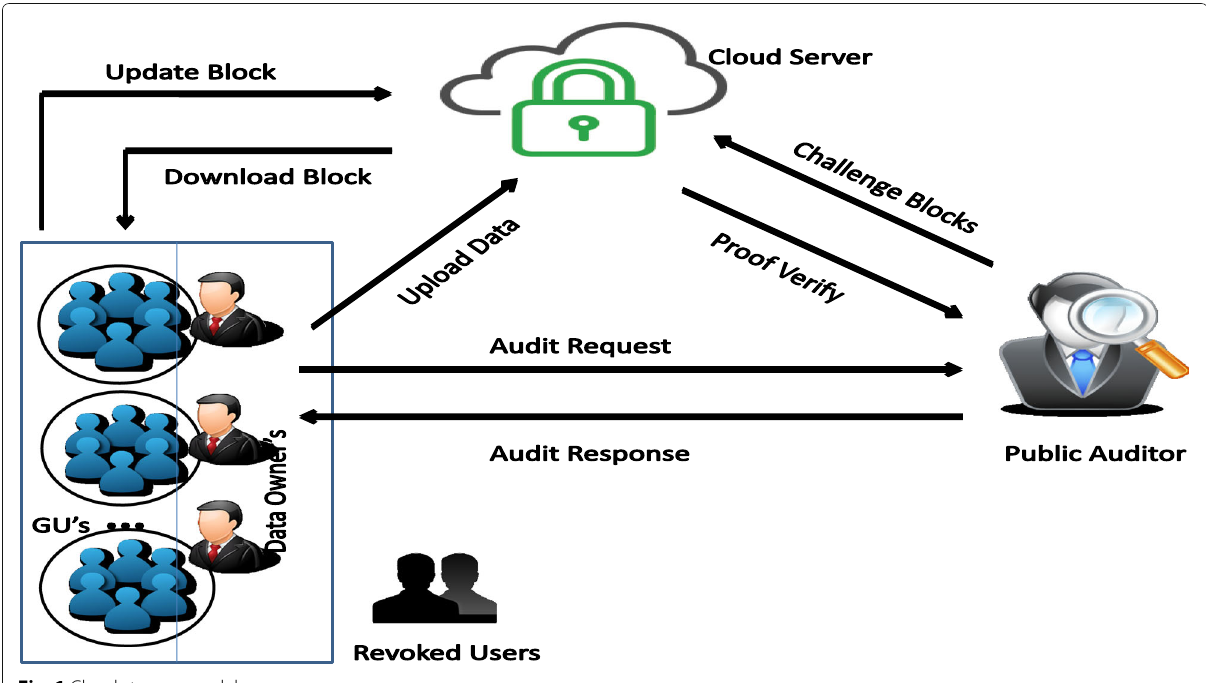
Fig. 1 Cloud storage model